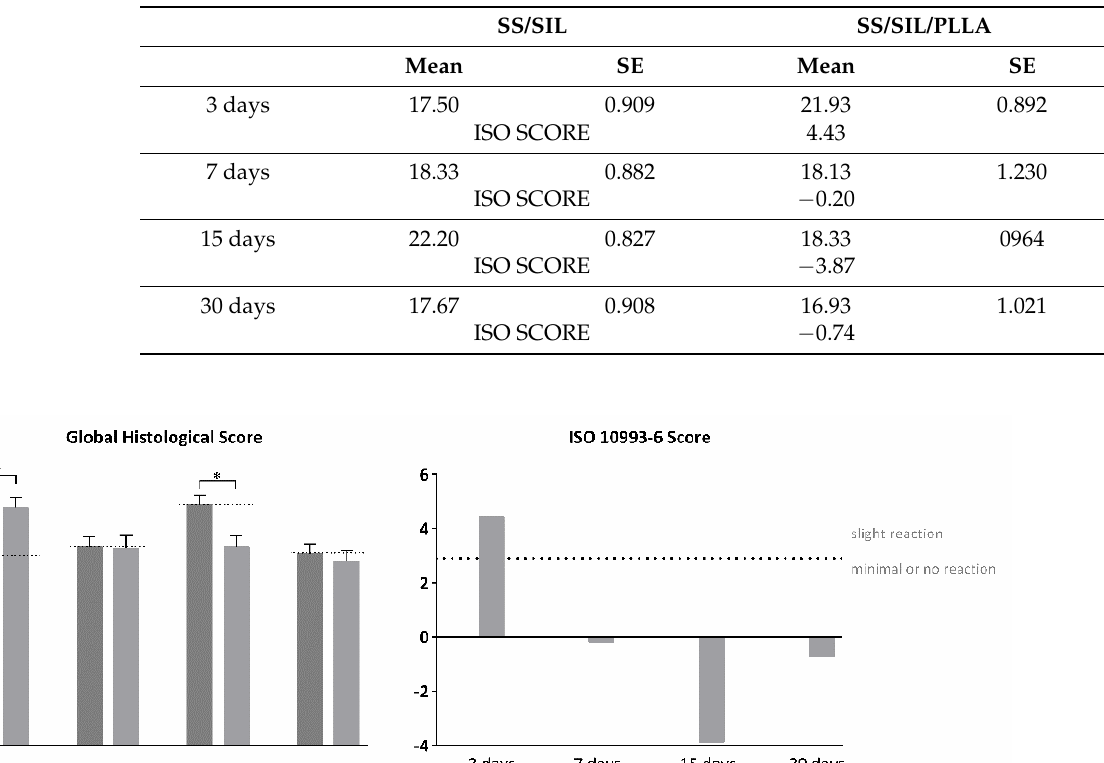
Table 5. Global histological scores presented as mean + SE for both devices, and ISO-10993-6 score at 3, 7, 15, and 30 days after implantation.